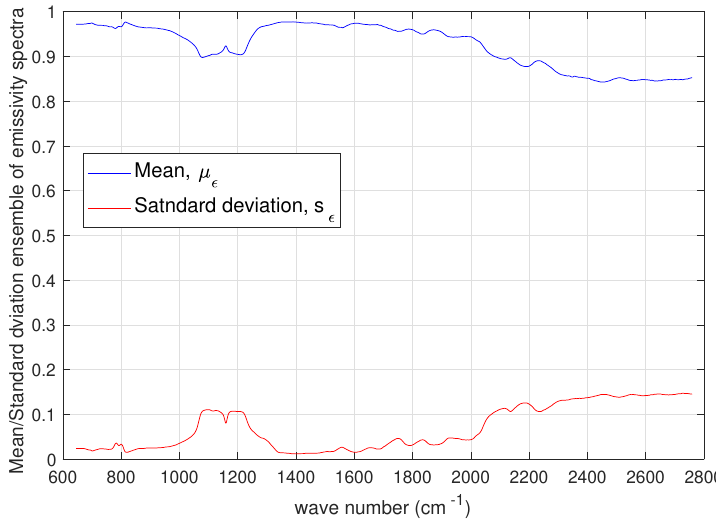
Figure 7. Mean and standard deviation of the ensemble of emissivity shown in Figure